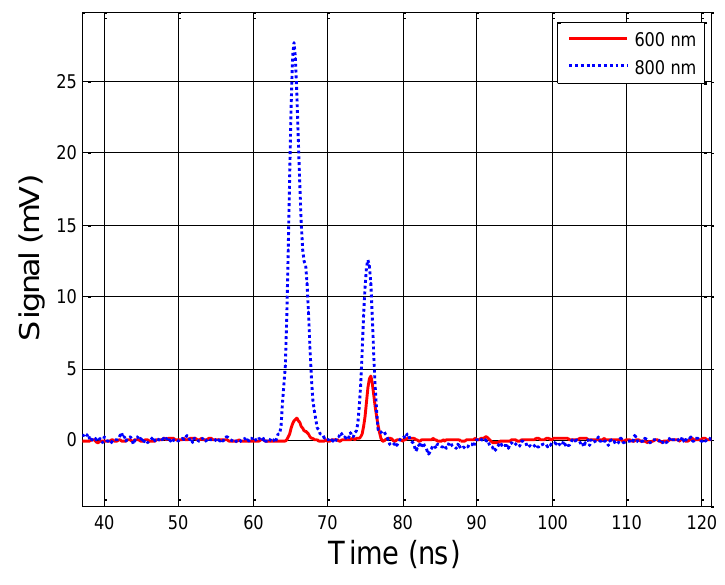
Figure 4. The echoes of the two-channel hyperspectral LiDAR for two targets (Spectralon panel behind the Norway spruce tree), averaged for 16 measurements.